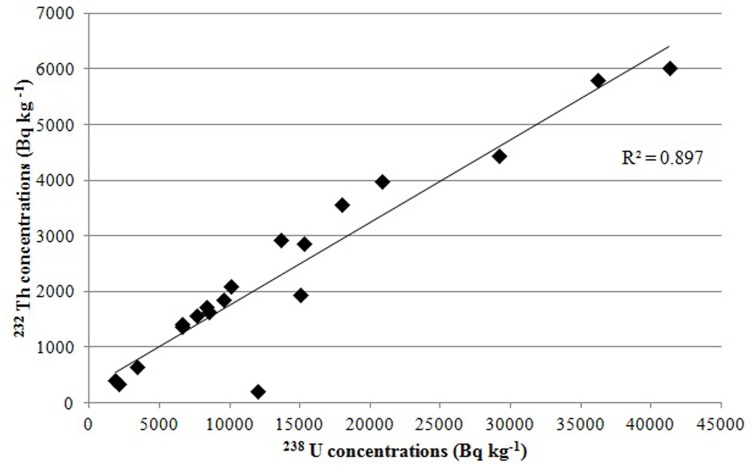
Correlation between 232Th and 238U in Chavara-Neendakara soils by gamma-ray spectrometry.